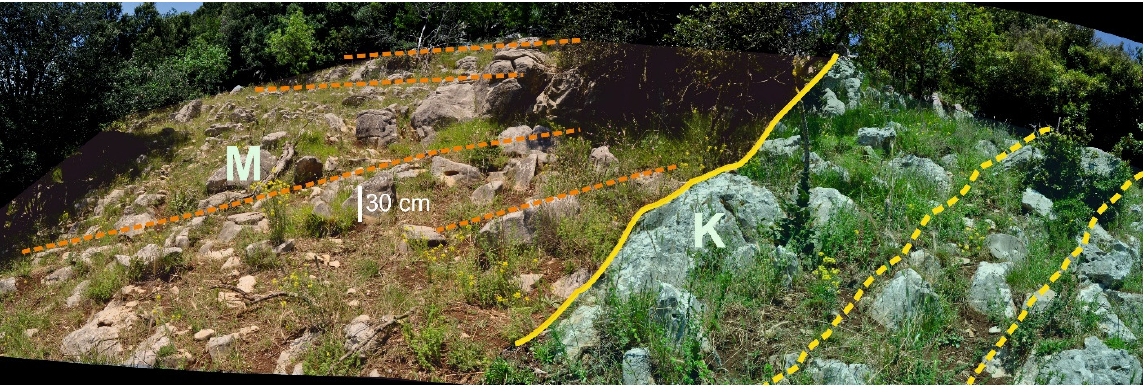
Figure 6. In the easternmost outcrop of South Western Prenestini, the Miocene carbonates (M) lie in onlap on the Cretaceous substrate (K) represented by Cenomanian obitolinids-rich grainstones.